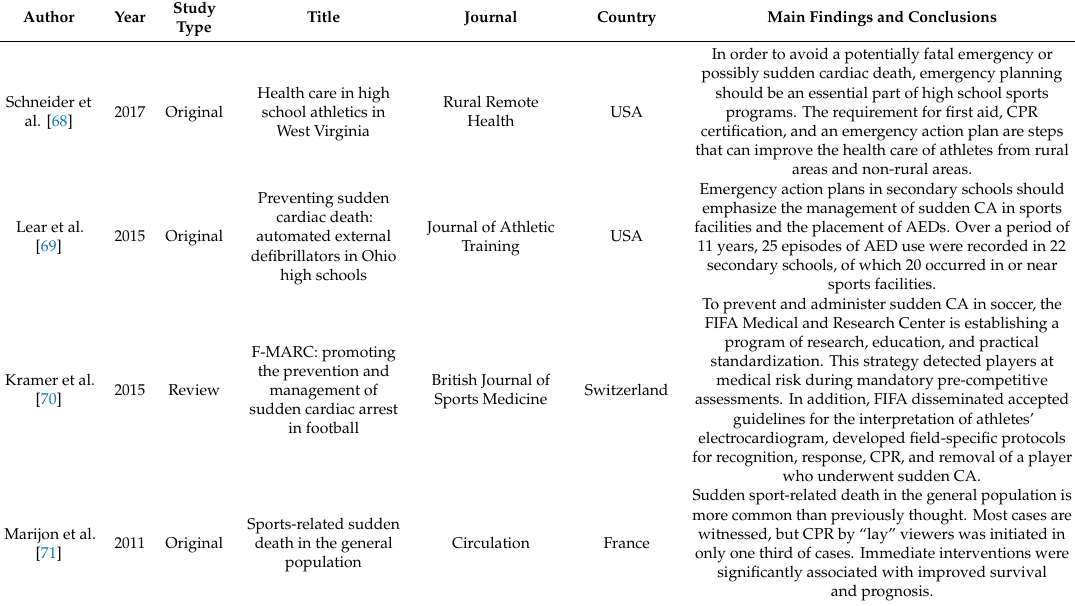
Table 6. Studies and their main conclusions and results related to first aid in the context of sport and physical